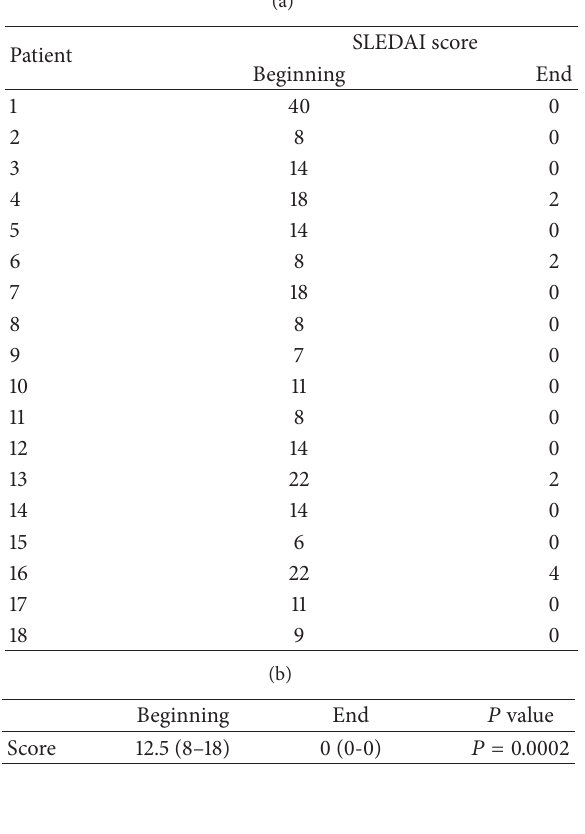
Table 2: SLEDAI Score in the initial and at the end of the last cycle of RTX.